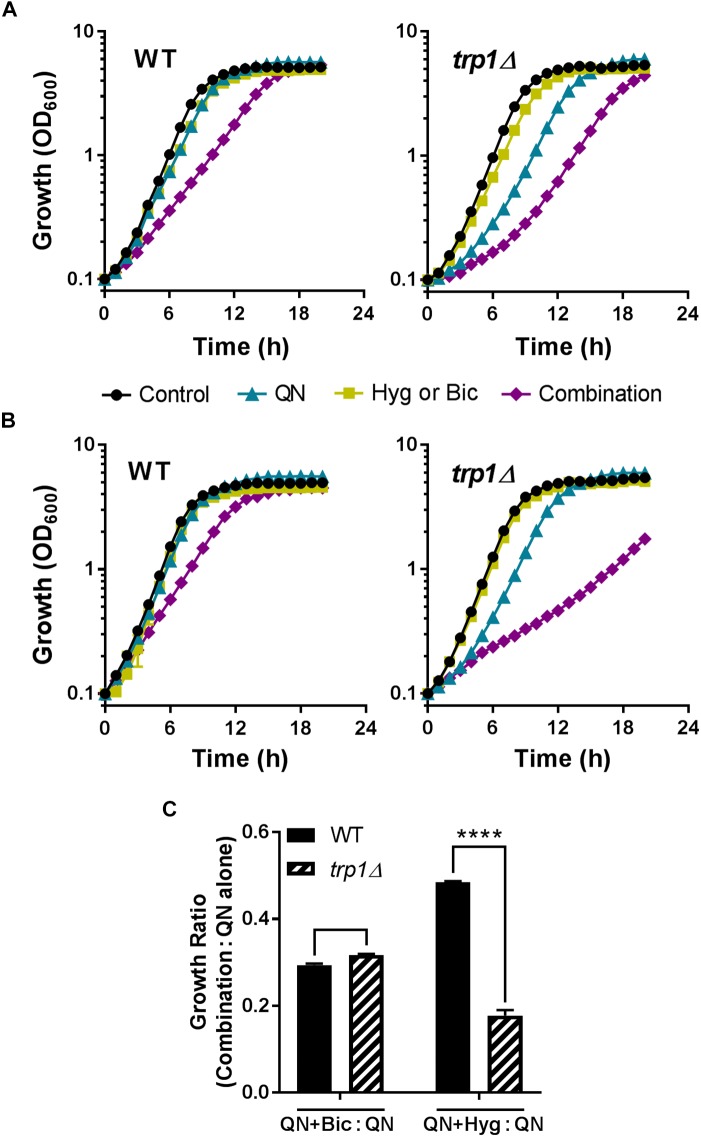
Tryptophan depletion can exacerbate quinine + hygromycin synergy. S. cerevisiae BY4743 and trp1Δ strains were cultured in either the absence or presence of 2 mM quinine hydrochloride (QN) and either sodium 6 mM bicarbonate (Bic) (A) or 3 μg/ml hygromycin B (Hyg) (B). (C) Growth ratios (combination:QN alone) were calculated from OD600 values at 10 h. ∗∗∗∗p < 0.0001 according to multiple comparisons (Sidak’s test) by two way ANOVA. The values are means ± SEM from three replicate experiments.